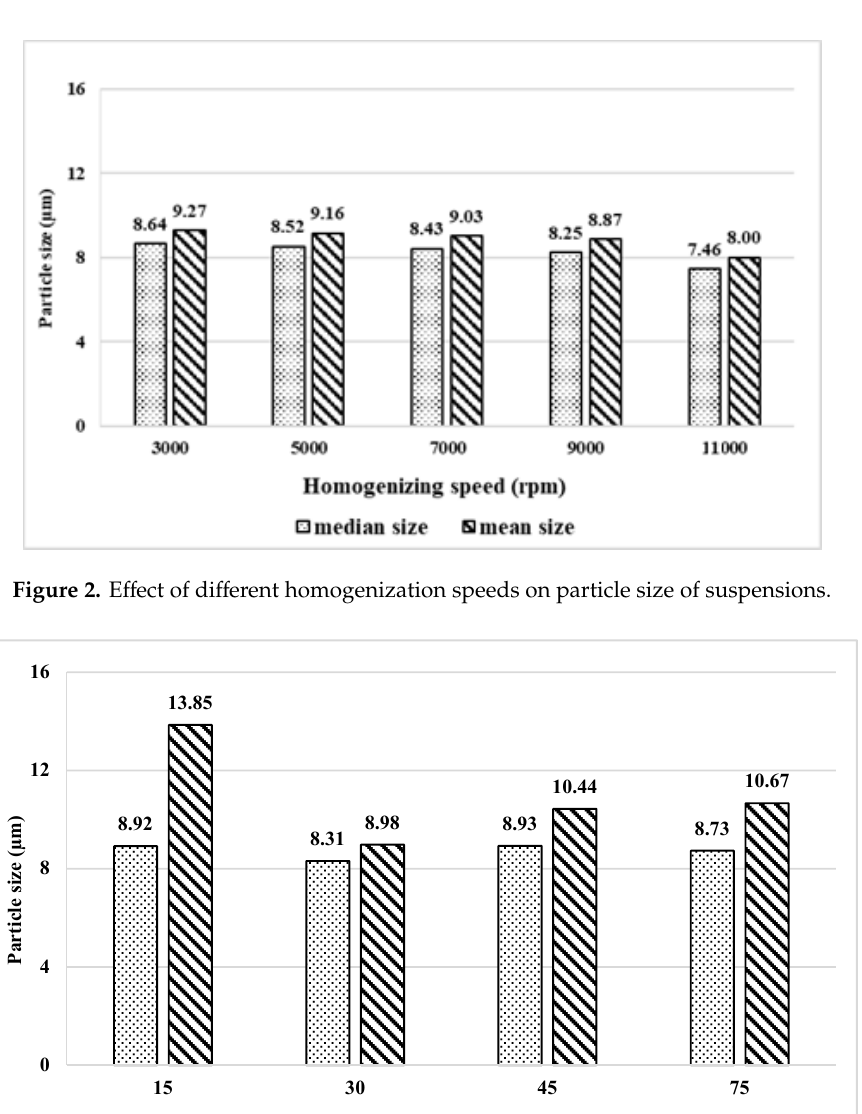
Figure 2. Effect of different homogenization speeds on particle size of suspensions.